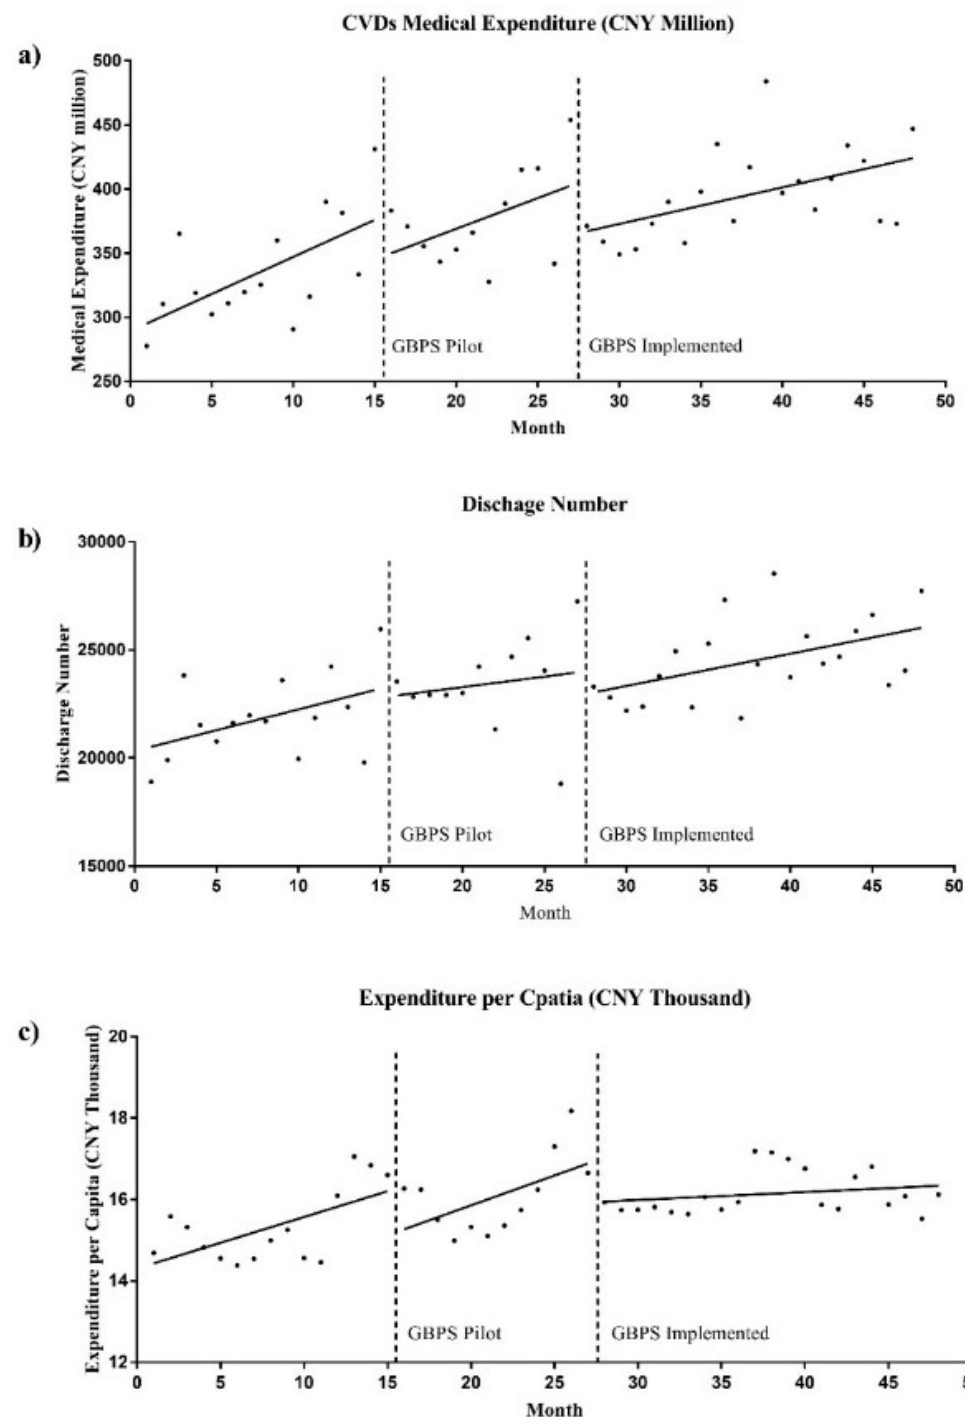
Figure 1. Monthly trend of medical expenditure, discharge number and expenditure per capita in study